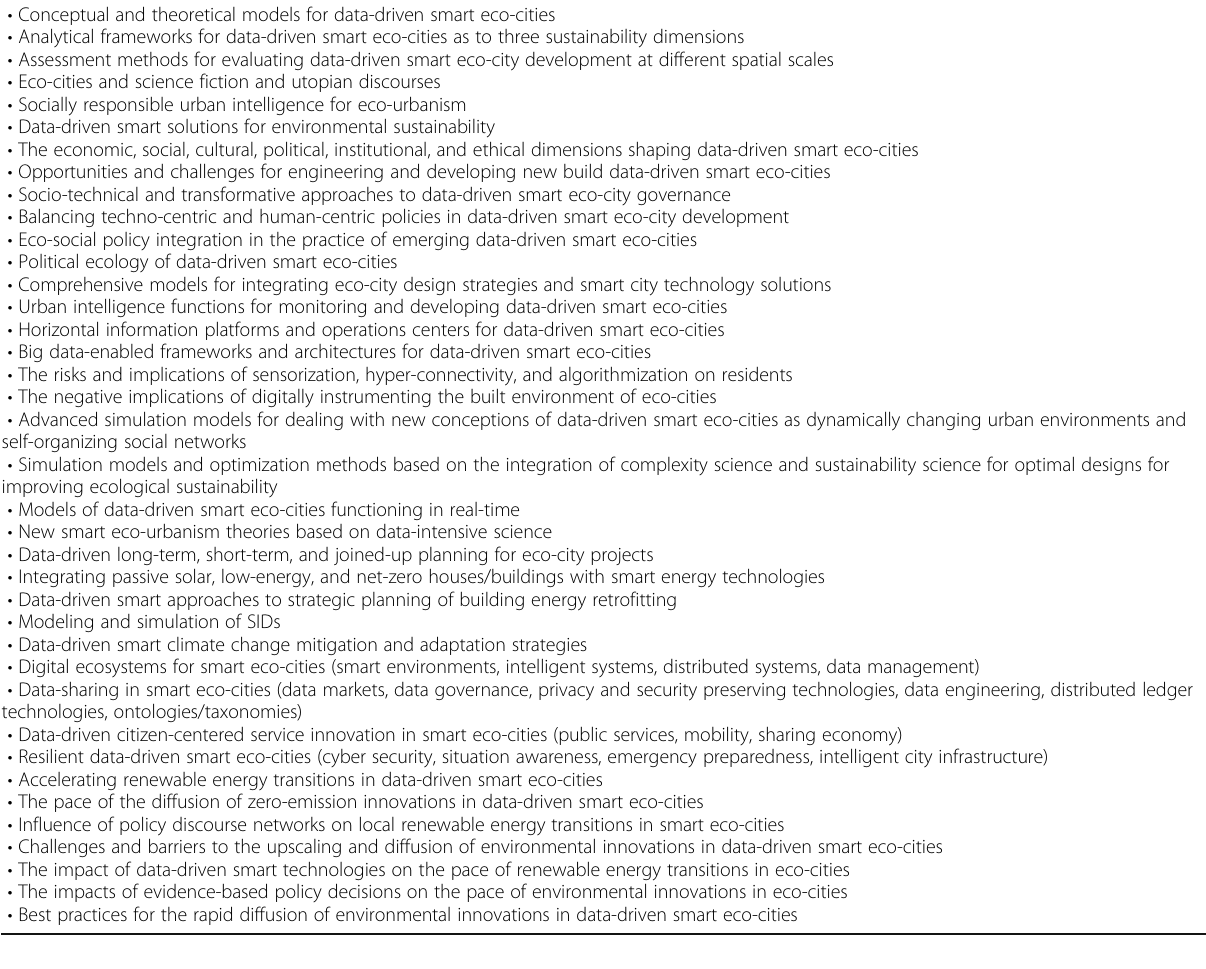
Table 7 Topics related to the knowledge gaps in the area of data-driven smart eco-cities (cid:129) Conceptual and theoretical models for data-driven smart eco-cities (cid:129) Analytical frameworks for data-driven smart eco-cities as to three sustainability dimensions (cid:129) Assessment methods for evaluating data-driven smart eco-city development at different spatial scales (cid:129) Eco-cities and science fiction and utopian discourses (cid:129) Socially responsible urban intelligence for eco-urbanism (cid:129) Data-driven smart solutions for environmental